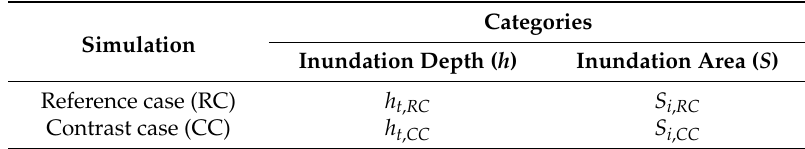
Table 2. Four categories of the simulated results encompassing the reference case (RC) and contrast case